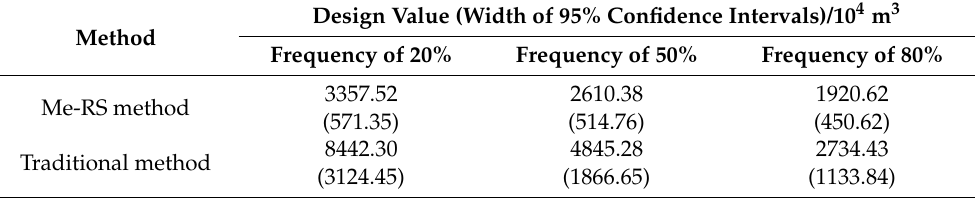
Table 6. Nonstationary design values and their uncertainties at different